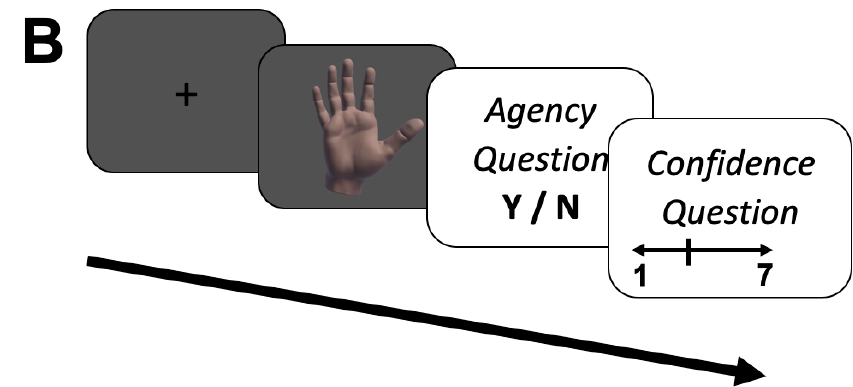
Figure 1. Experimental set-up and trial flow for the experiment. ( A ) Experimental set-up. The participant’s hand is hidden from his view by the barrier, and the camera mounted above his hand records movement and presents it on the screen in front of him as a VH. ( B ) Trial flow. In each trial, a fixation cross was followed by a VH that moved with/without an alteration. Following the VH’s presentation, in experiments 2–4, participants judged “same”/ “not same” in response to the question “Was the movement of the VH identical to my movement?” (i.e., agency question) and rated their